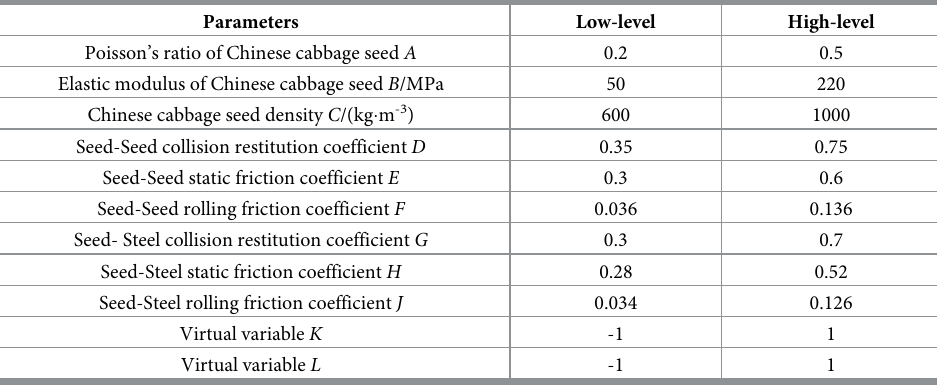
Table 2. Simulation parameters setting of Chinese cabbage seeds.